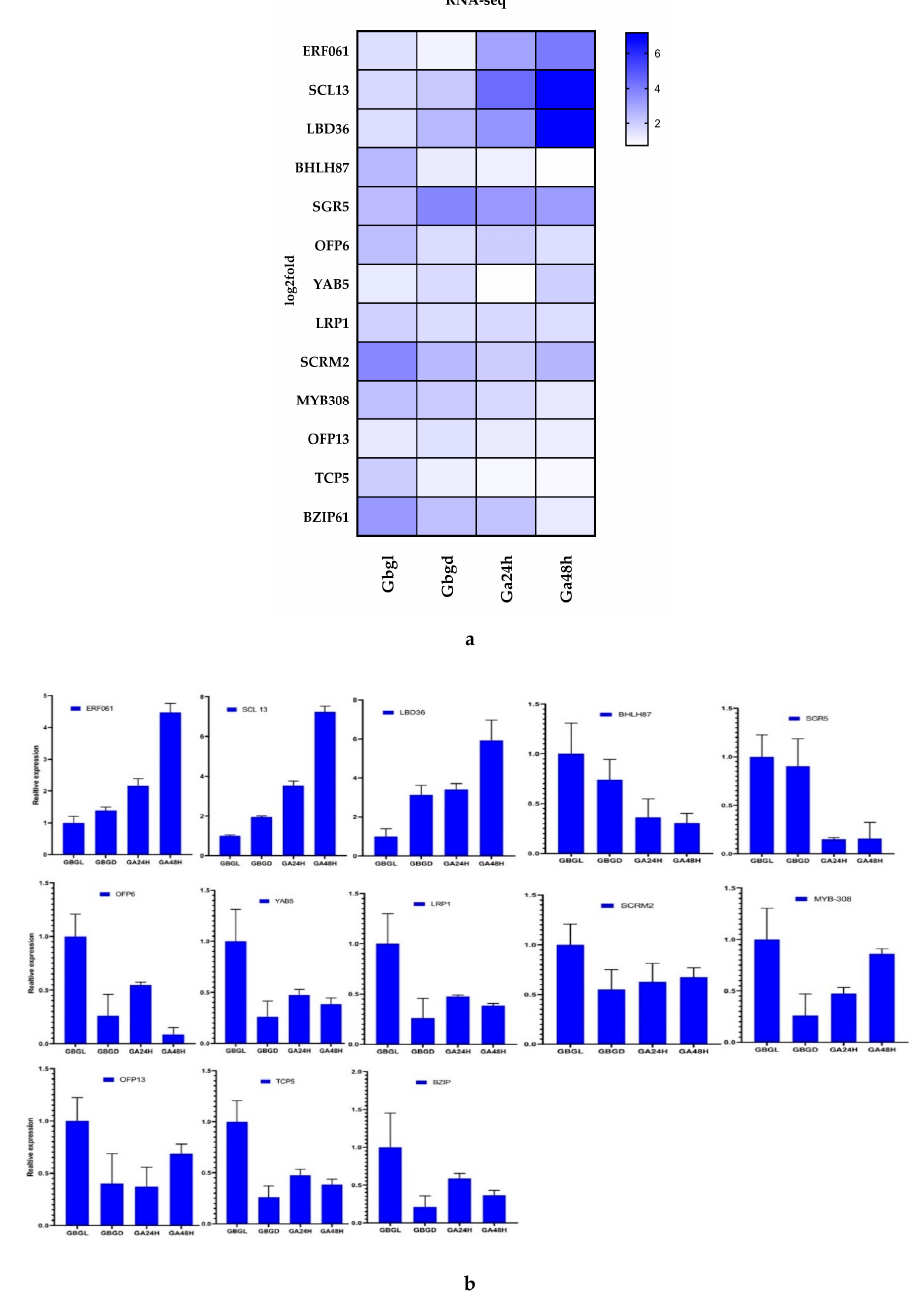
Figure 9. Validation of 13 DEGs related to delayed gland morphogenesis identified from transcriptome analysis data by quantitative reverse-transcription polymerase chain reaction (qRT-PCR). ( a ) RNA-seq-based log2-fold change expression; ( b ) qRT-PCR-based relative expression